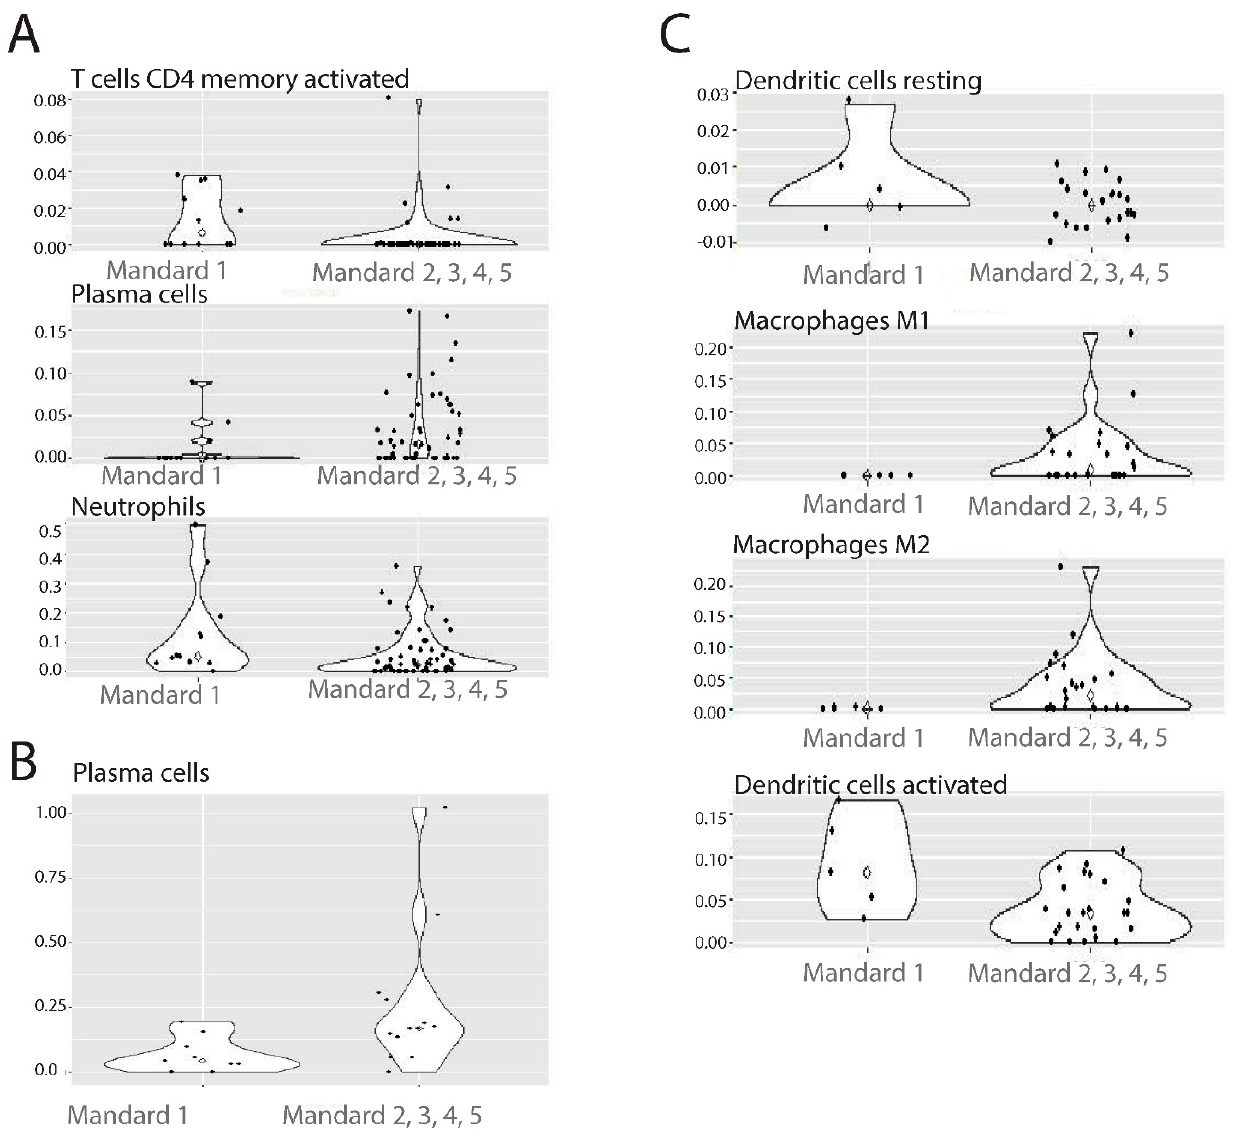
Figure 5. ( A ) CIBERSORTx Mandard Violin plots AUMC. ( B ) CIBERSORTx Mandard Violin plots Erasmus MC. ( C ) CIBERSORTx Mandard Violin plots NKI. Every dot depicts a sample. White diamond depicts median value.